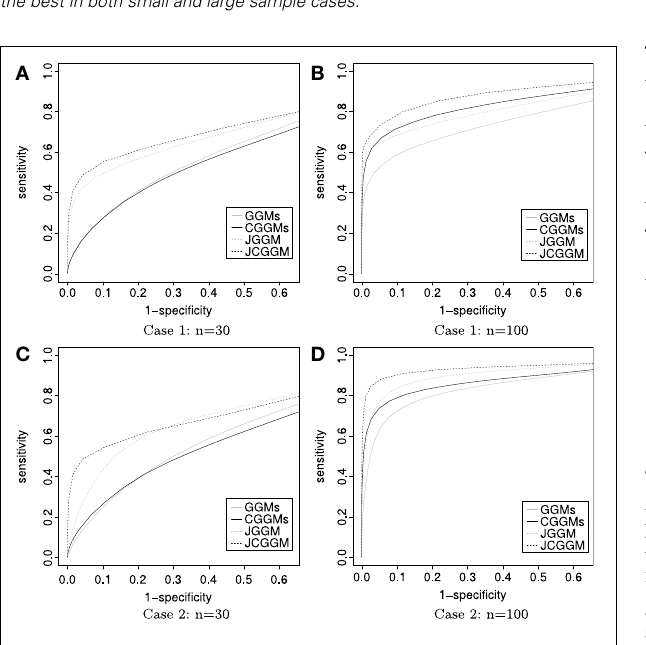
The results are given in Table 3 . First, in both JGGM and JCGGM, the liver networks have the largest numbers of edges.